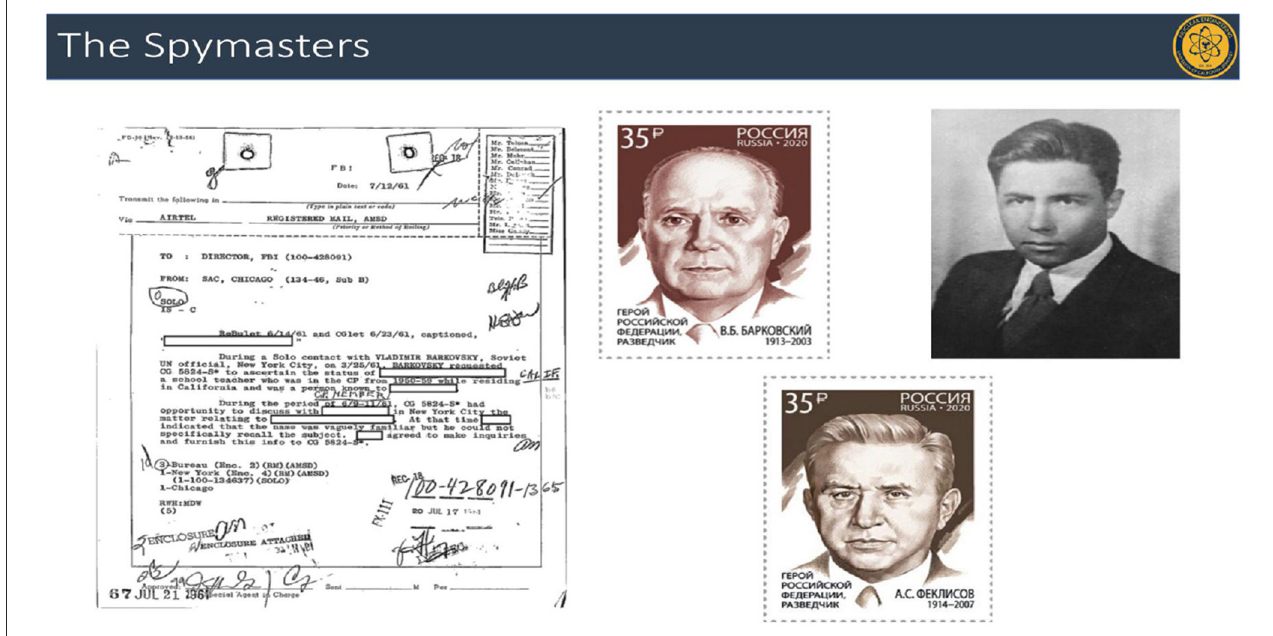
FIGURE15 Slides describing Soviet spymasters.